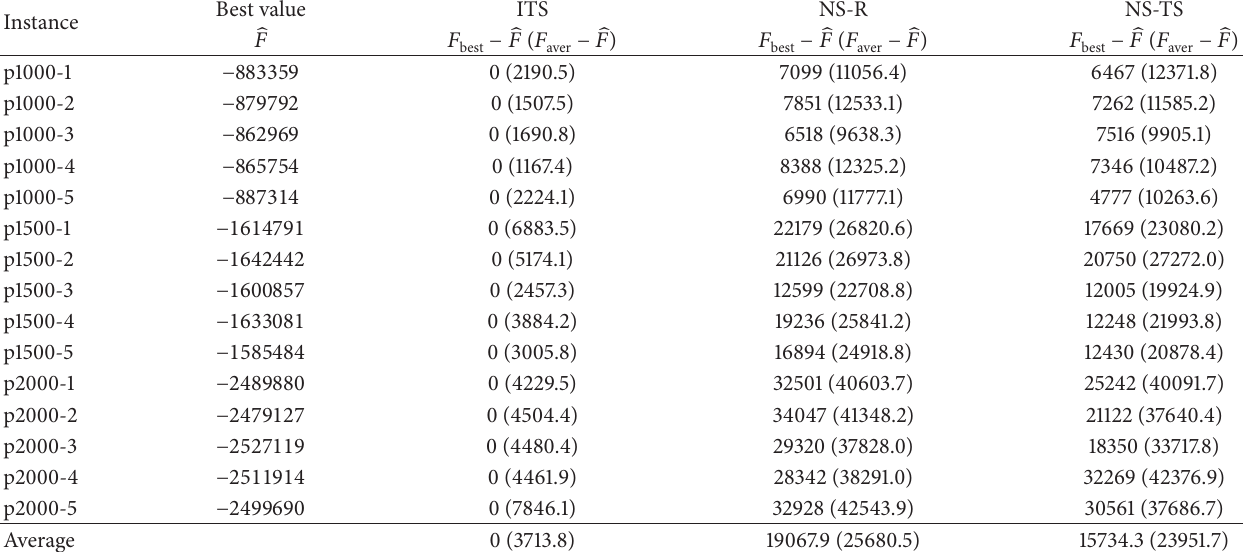
Table 3: Comparison of ITS with NS-R and NS-TS on larger CPP